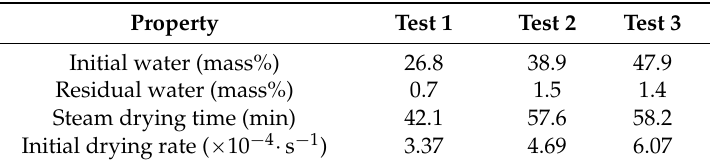
Table 3. Initial and residual water percentages ( WP ) and steam drying time of 10 mm sample at the test temperature of 150 ˝